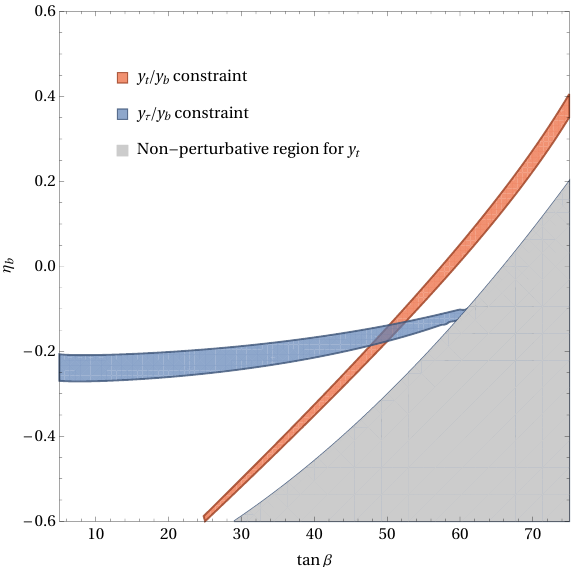
Figure 3 . Allowed regions in the tan (cid:12) - (cid:17) b plane consistent with Yukawa ratios of 3rd family being equal to 1.